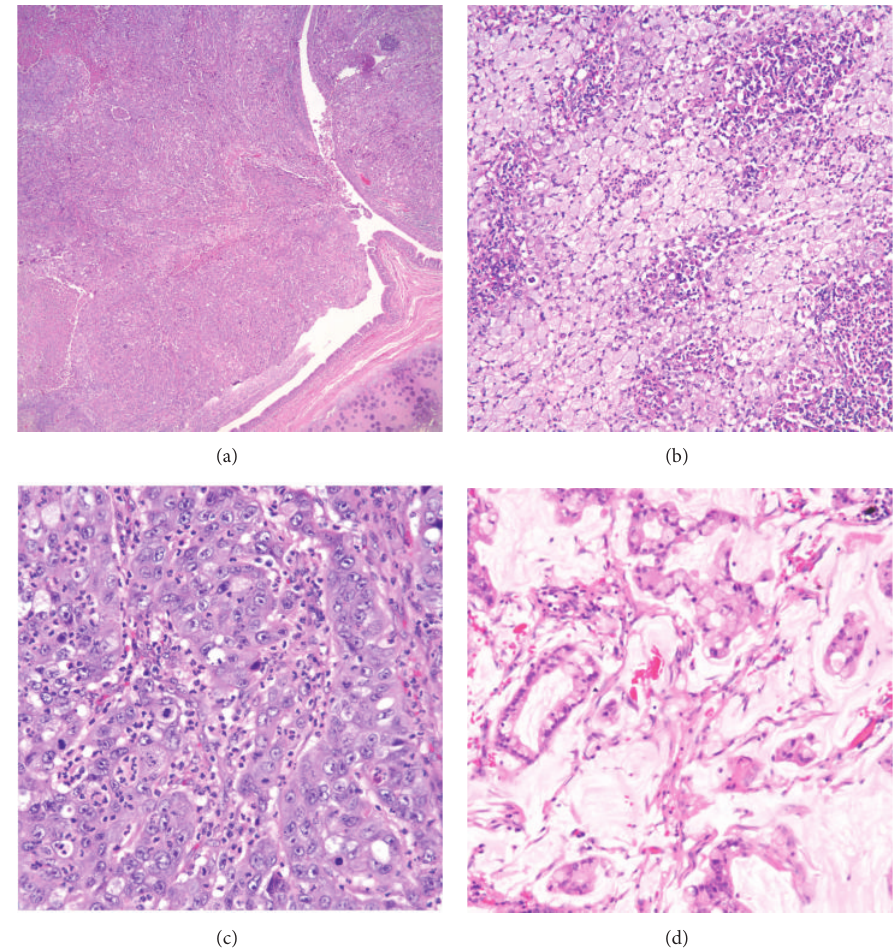
Figure 2: (a) Hematoxylin and eosin (H & E) stain showing endobronchial invasion of mucoepidermoid carcinoma. (b) H & E staining showing the mucinous component of mucoepidermoid carcinoma. (c) H & E staining showing the solid component of mucoepidermoid carcinoma. (d) H & E staining of mucinous